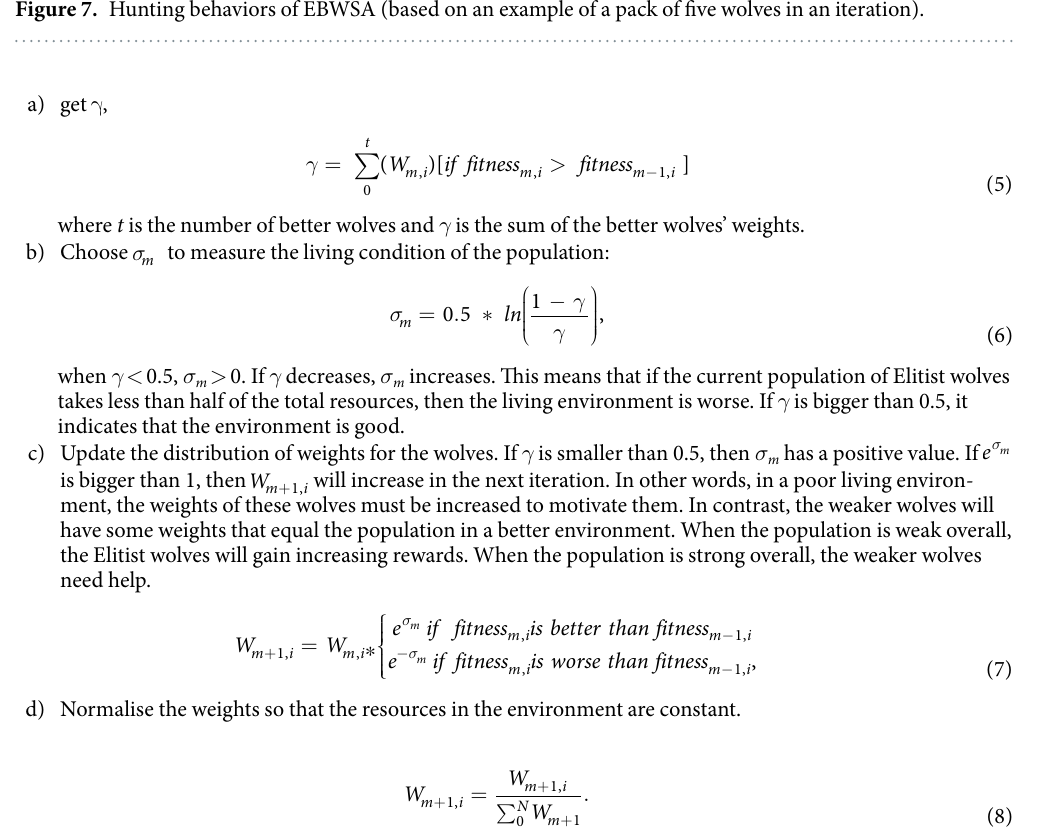
Figure 7. Hunting behaviors of EBWSA (based on an example of a pack of five wolves in an